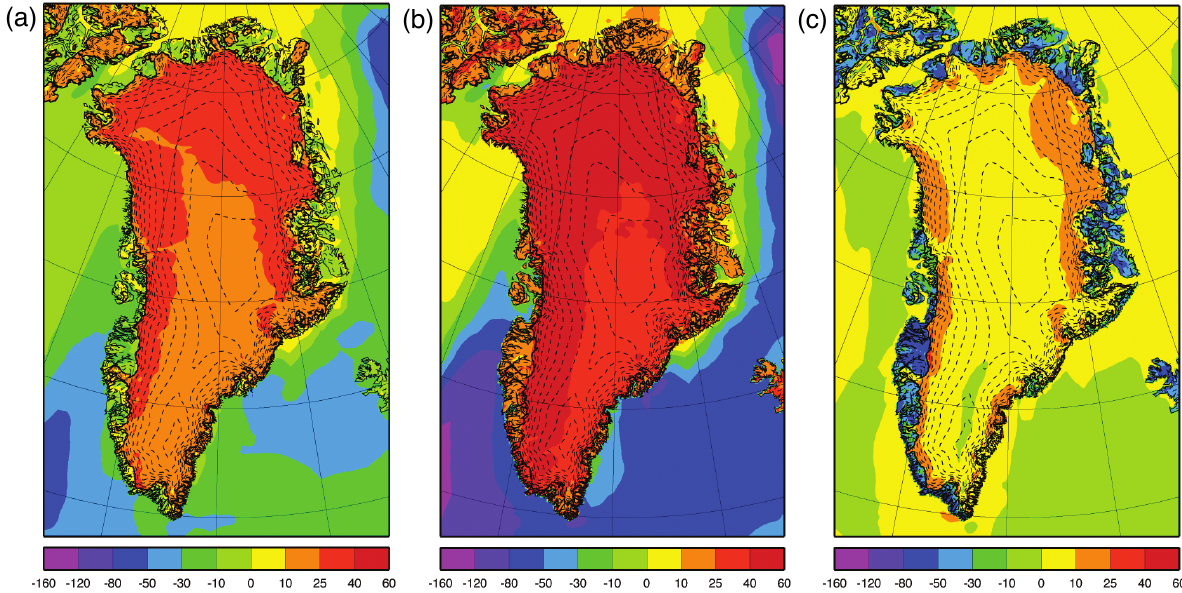
Fig. 13. Averaged turbulent sensible heat flux SHF [Wm − 2 ]) over (a) a year, and the seasons (b) DJF and (c) JJA.